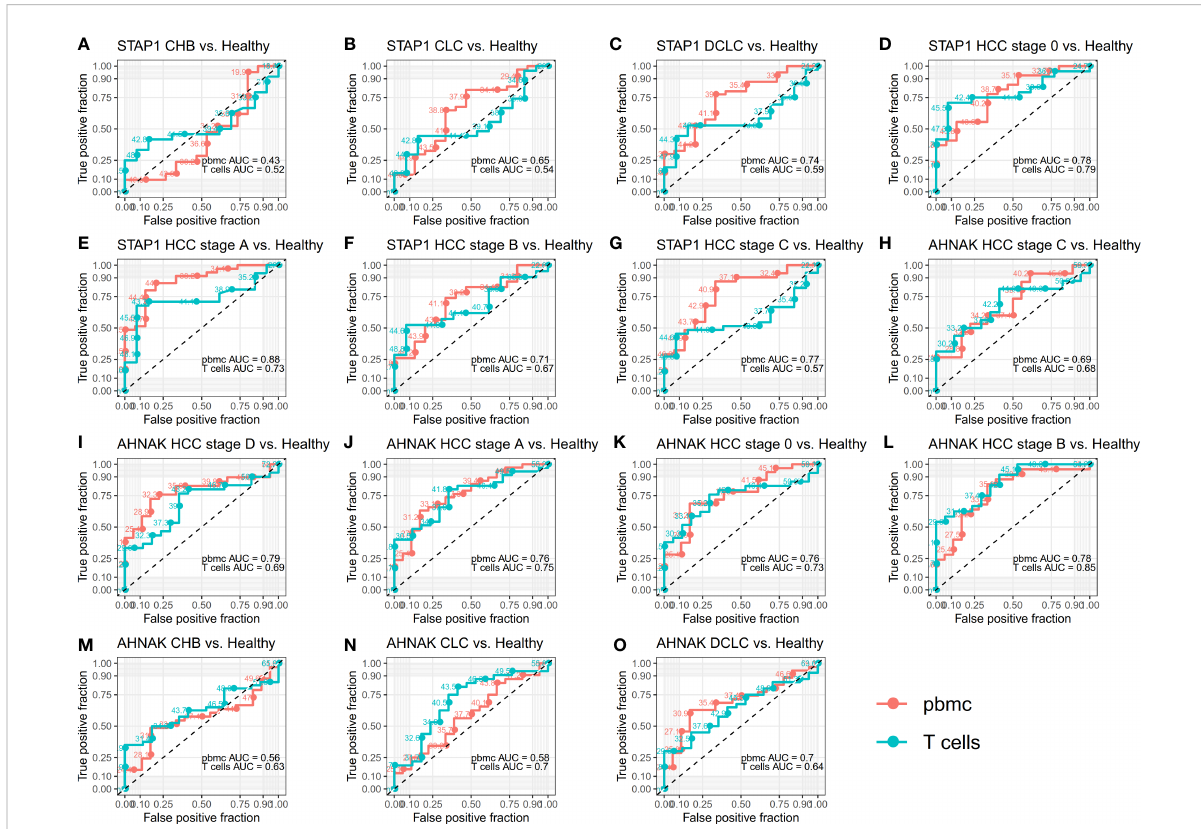
FIGURE 2 Receiver operating characteristic (ROC) curves for whether STAP1 or AHNAK methylation in peripheral blood mononuclear cells (PBMC) can be used as an indicator for the diagnosis of liver disease. (A – G) ROC curves for methylation of STAP1 in PBMC and T cells. (H-O) , ROC curves for methylation of AHNAK in PBMC and T